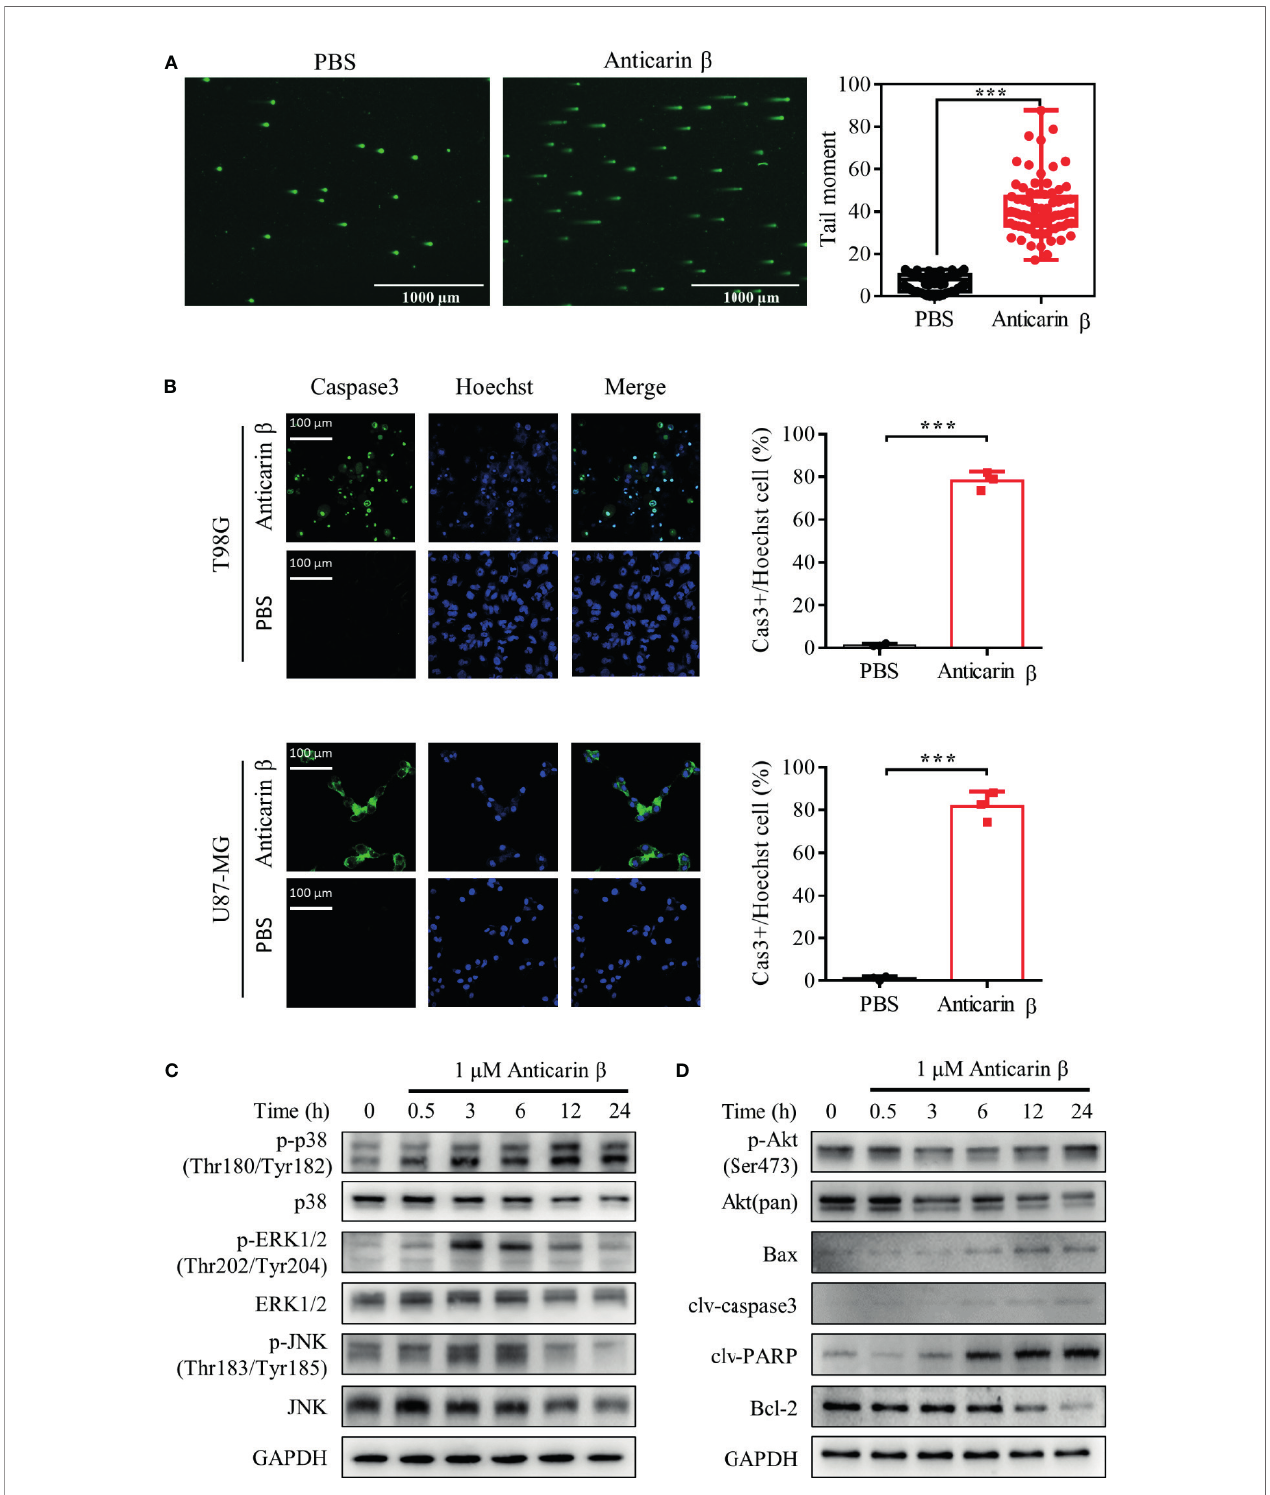
FIGURE 4 | Anticarin b induces apoptosis by DNA damage in human glioma cells. (A) The DNA damage in human glioma cell lines U87-MG treated with anticarin b (1 m M) for 12 hours was measured using the neutral comet assay. Scale bar, 1000 m m. (B) U87-MG and T98G cells were treated with anticarin b (1 m M) or PBS for 24 hours, followed by fl uorescence analysis of caspase 3 probe (green) and Hoechst 33324 (blue). Scale bar, 100 m m. (C, D) Western blotting analysis showed the time-dependent effects of anticarin b (1 m M) in U87-MG cells on Akt, MAPKs signal pathways, and apoptotic-related proteins. Data are presented as mean ± s.d. of three independent experiments conducted in duplicate, *** P < 0.001 versus the control